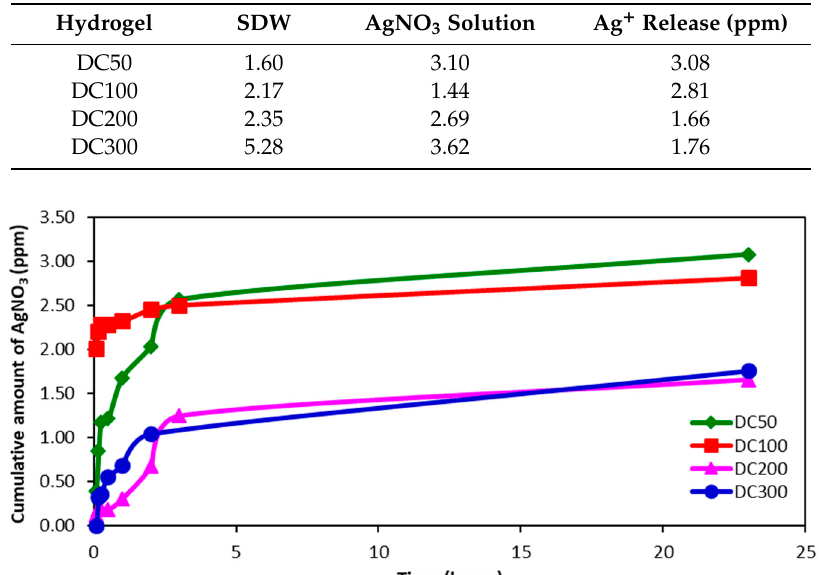
Table 3. Swell ratio ( w / w ) of hydrogels after 24 h in sterile distilled water (SDW) or 0.0508% AgNO 3 solution.